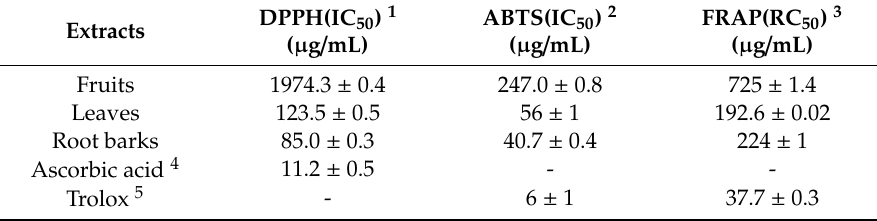
Table 3. Antioxidant capacity of fruit, leaf and root bark extracts.